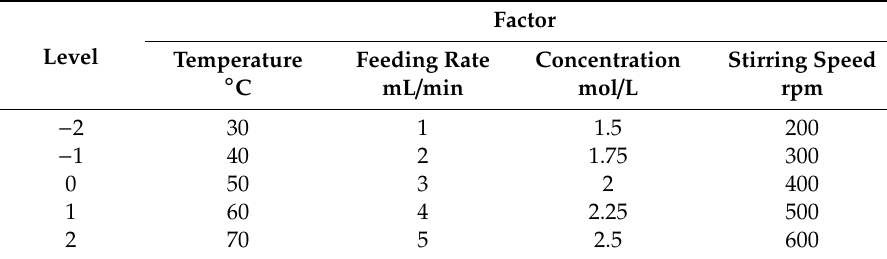
Table 5. Levels and codes of central composite design.